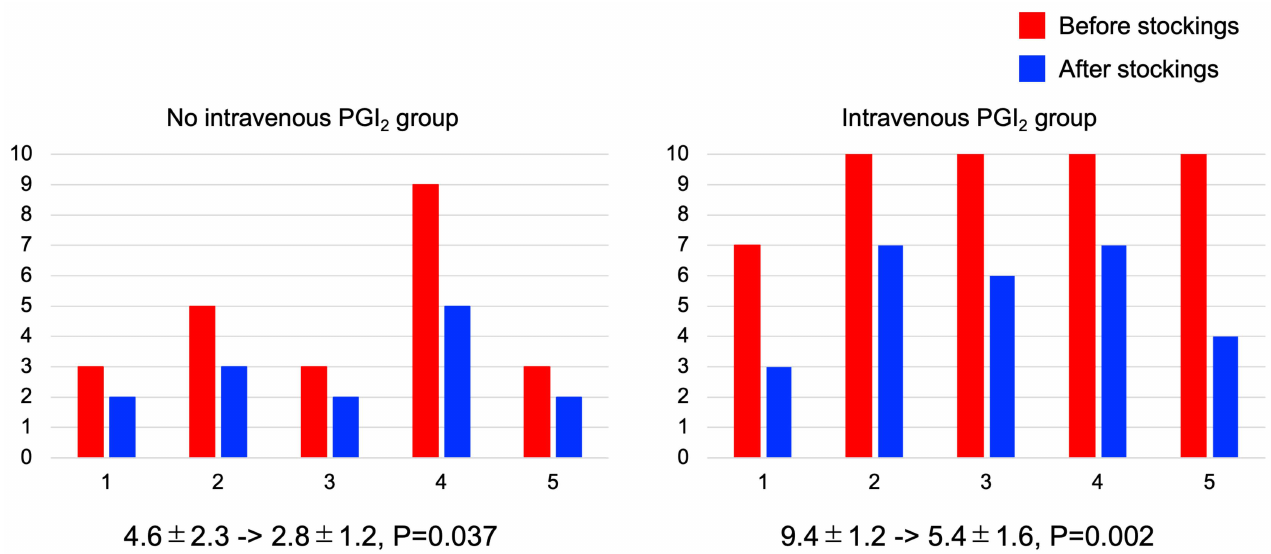
Figure 1. Effects of compression stockings evaluated by Numeric Rating Scale for Pain (NRS). In intravenous prostacyclin analogue (PGI 2 ) group, four of five patients had score 10 (worst) before stockings. Wearing compression stockings significantly improved NRS score in both